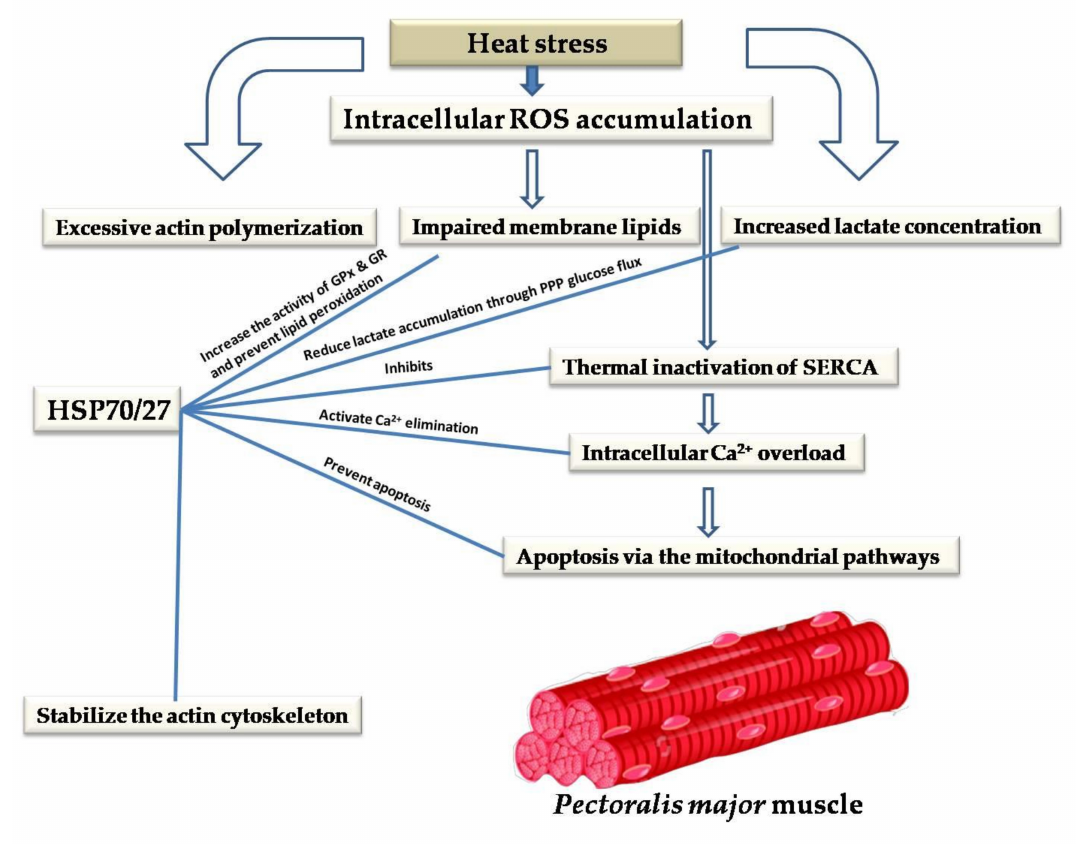
Figure 4. Potential mechanisms underlying the cytoprotective role of HSPs against heat-stress-induced impairment of skeletal